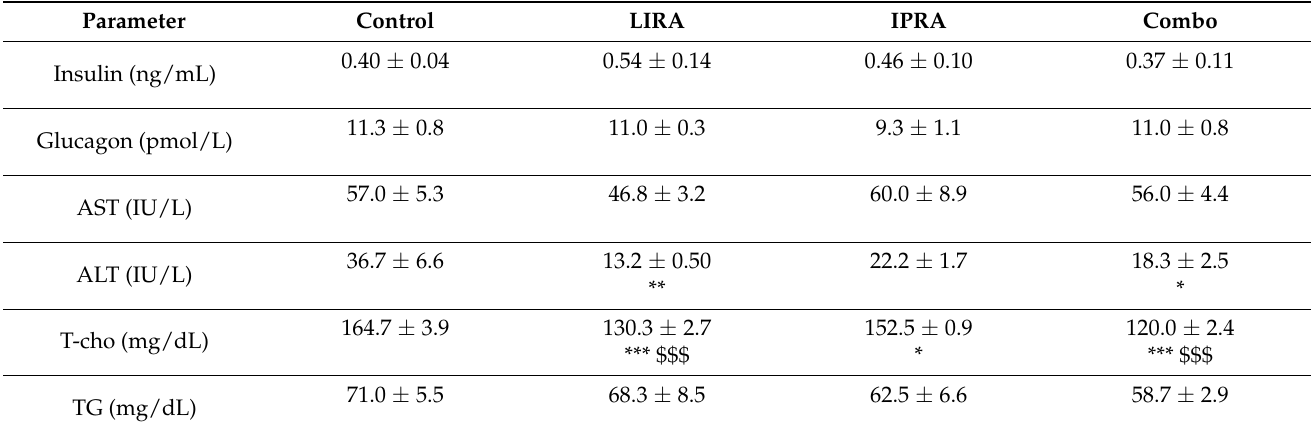
Table 1. Plasma biochemical parameters in DIO mice after drug